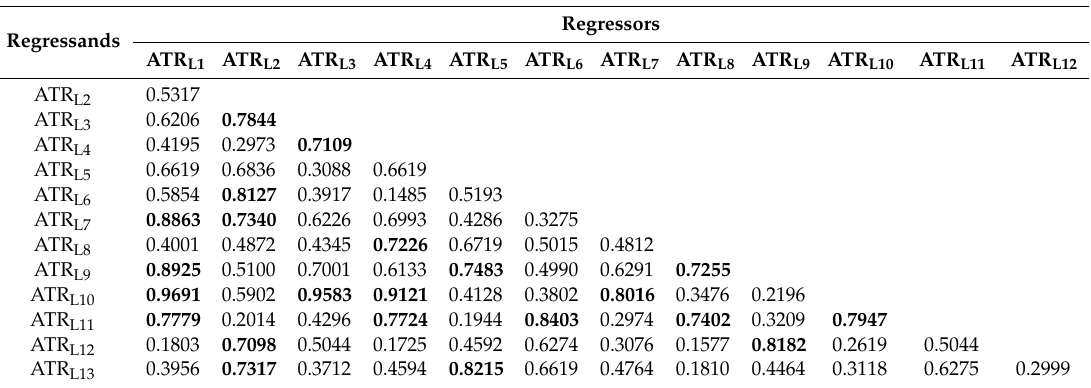
Table 3. Correlation matrix for type I territories.